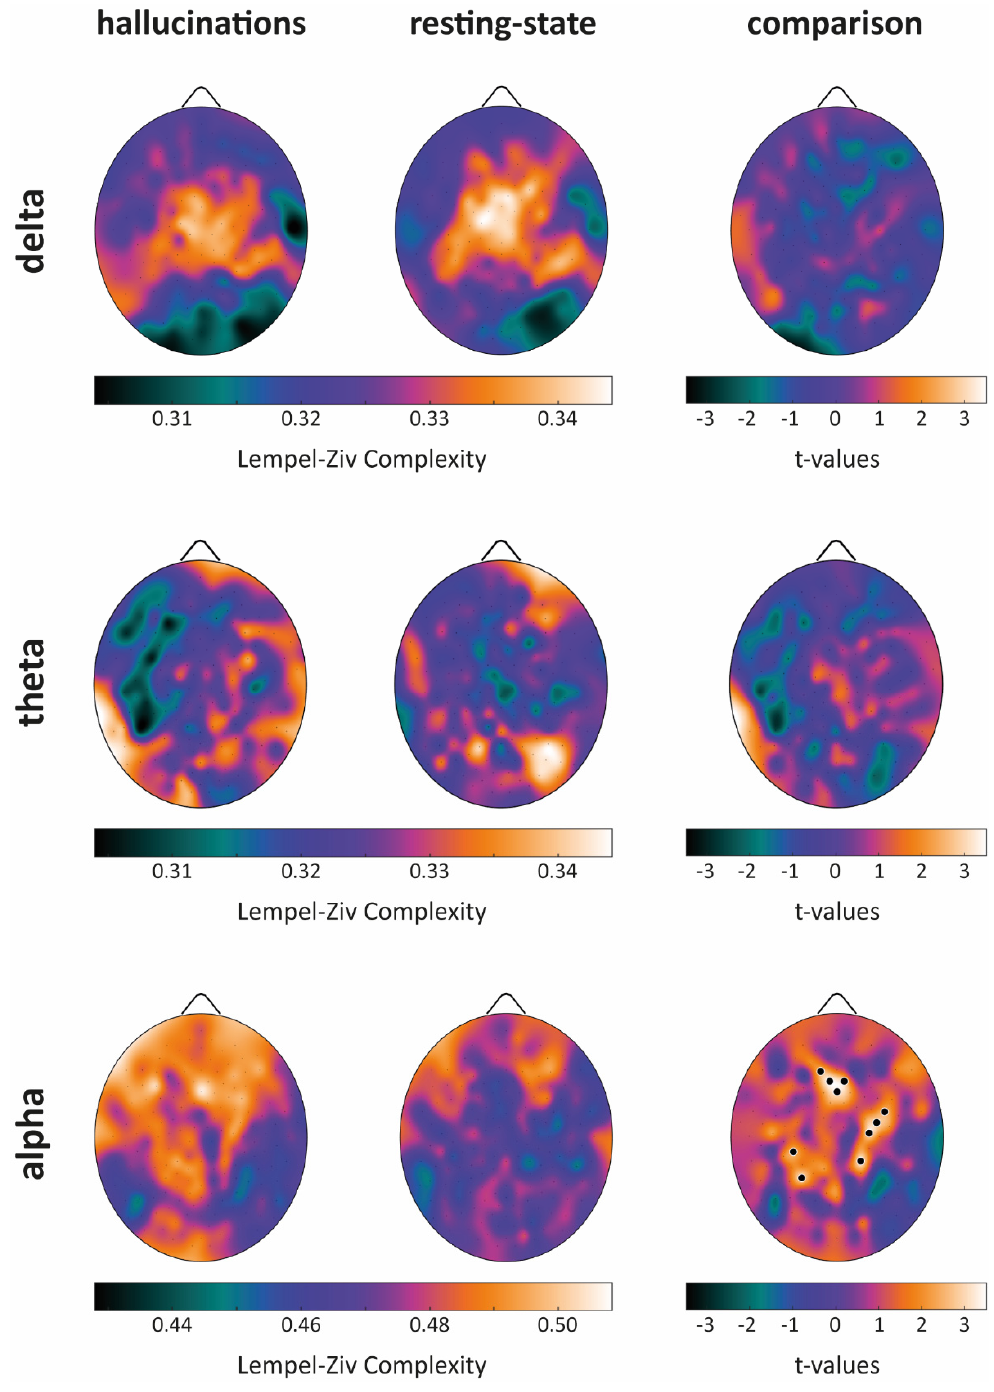
Figure 5. Average Lempel-Ziv complexity (LZC) scalp maps for each band and condition are presented in the first two columns. Band-wise comparisons are presented in the third column. Black dots indicate electrodes showing a significantly higher LZC during the VH condition as compared to the RS one, white dots (if present) indicate the opposite relationship. The critical t-value (in absolute value) for significance at p = 0.05 is |t| = 2.41 (single threshold tests for the maximum t-statistics).